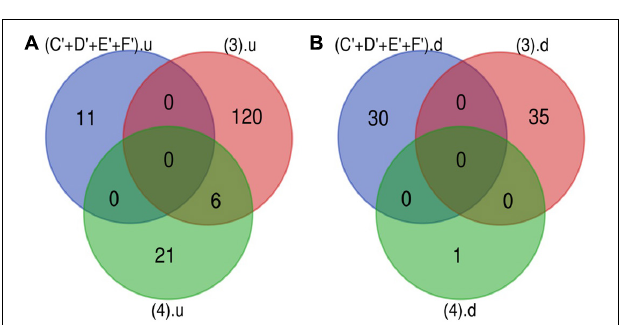
FIGURE 3 | microRNA specific for DR. (A) Upregulated miRNA: 11 up-regulated miRNAs are uniquely present in DR cases. (B) Downregulated miRNA: 30 down-regulated miRNAs are uniquely present in DR cases (C’+D’+E’+F’).u: (up-regulated miRNA in DR); (3).u: (up-regulated miRNA in DN); (4).u: (up-regulated miRNA in DFU); (C’+D’+E’+F’).d: (down-regulated miRNA in DR); (3).d: (down-regulated miRNA in DN); (4).d: (down-regulated miRNA in